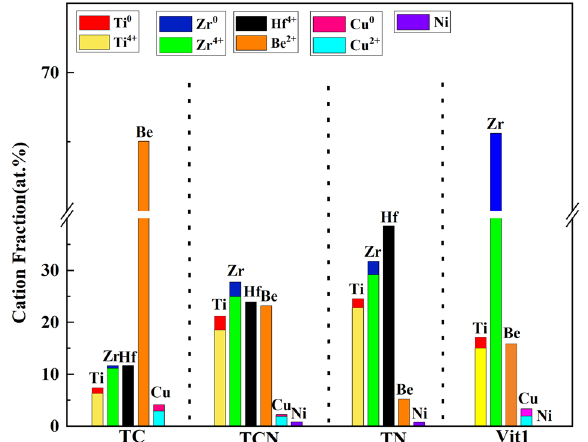
Fig. 9 Cation fractions in the passive fi lms of different alloy samples obtained by XPS analysis. The adopted samples were immersed in 3.5 wt. % NaCl solution for 2